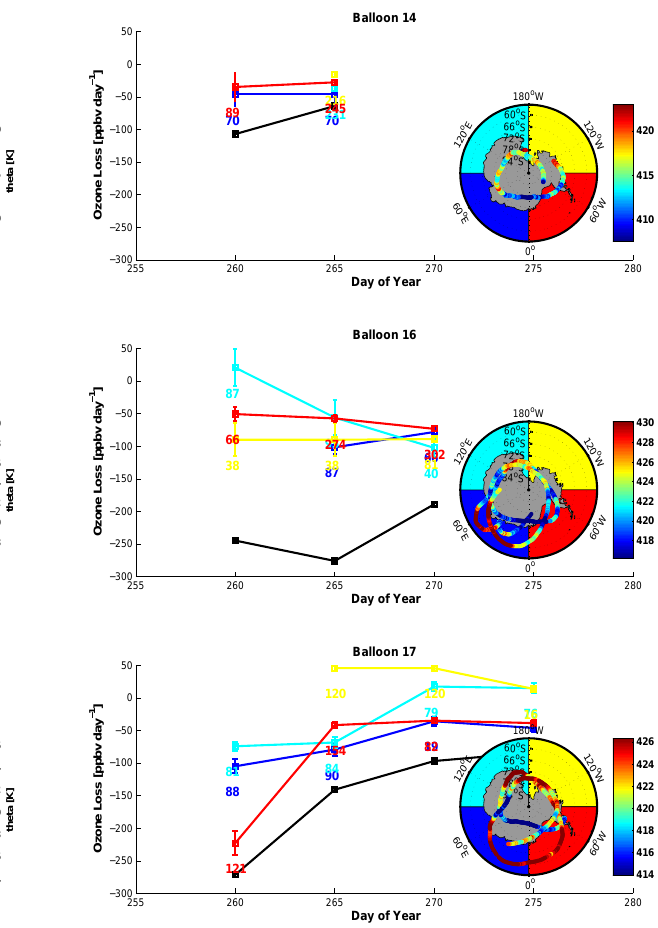
Figure 3. Ozone loss per sunlit hour for all of the matches for each of the ozone instrumented Concordiasi balloon flights. The matches are binned into the longitude quadrant of their end match (blue 0– 90 ◦ E, turquoise 90–180 ◦ E, yellow 90–180 ◦ W and red 0–90 ◦ W). While each match requires the potential temperature to be within 1K, all matches with an initial or end match within ± 5 days are binned to give the ozone versus sunlit hour regression shown. This way a match ending on day 263 will be represented in both the 260 and 265 data points above. The colour bar is used to indicate the potential temperature of the ozone observations as plotted with dots on the map. The error bars represent the standard error of each re- gression fit, and the coloured numbers are the number of matches used in the regression fitting. Also shown are simulated ozone loss rates calculated by running a chemical box model along the longest match trajectory for each time bin (black line). The box model as- sumes ClO x =Cl y and JPL 2011 kinetics.